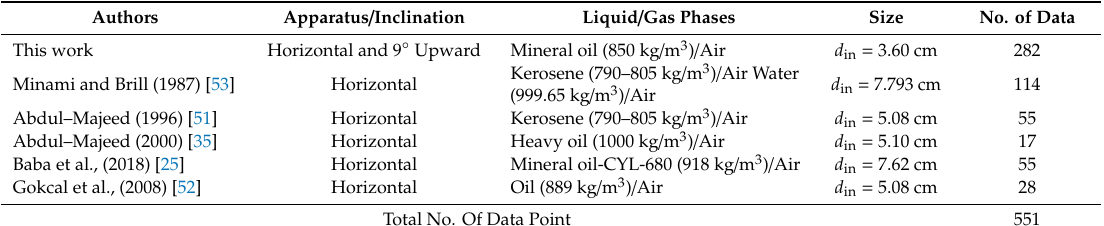
Table 1. Data used to validate the proposed